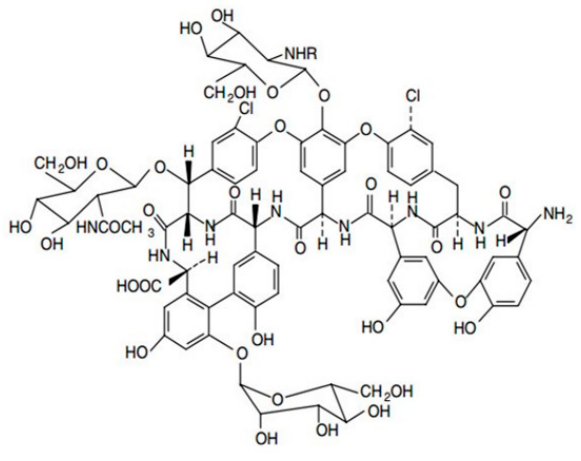
Figure 2. Structure of the teicoplanin-based chiral selector.